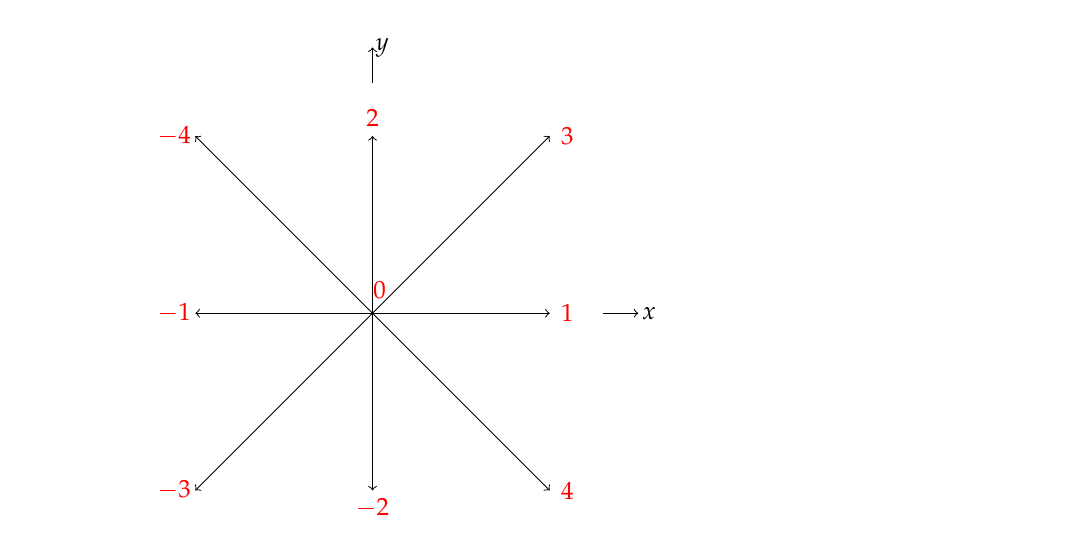
Figure 1. Two-dimensional nine-velocity lattice ( D 2 Q 9). Lattice velocities are labeled by red